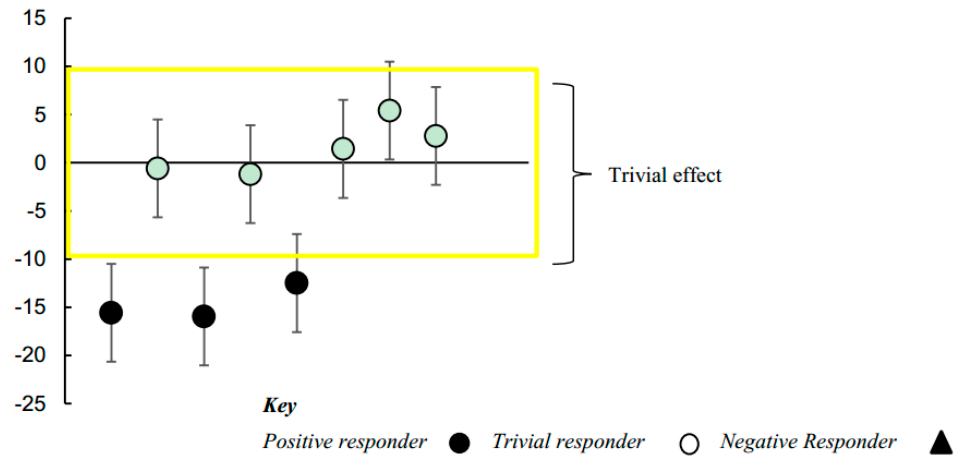
Figure 3. Pre-post study changes in Compulsive Behaviors for individual children, with 95% confidence limits.